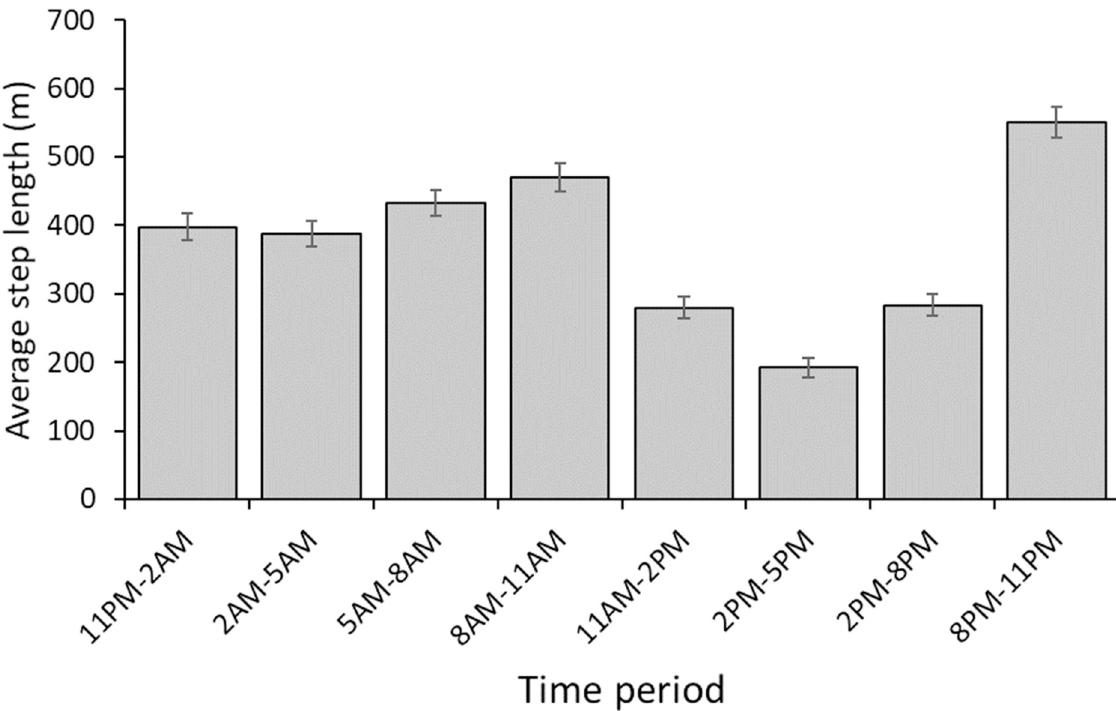
Fig 2. Average three-hour step lengths (with 95% confidence intervals) of GPS-collared wild pigs on Fort Hood Military Installation in 2016–2017.